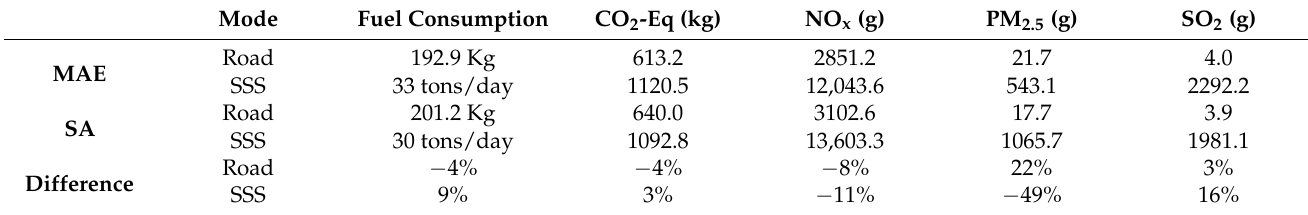
Table 11. Comparison of results with MAE calculator—SSS-based route